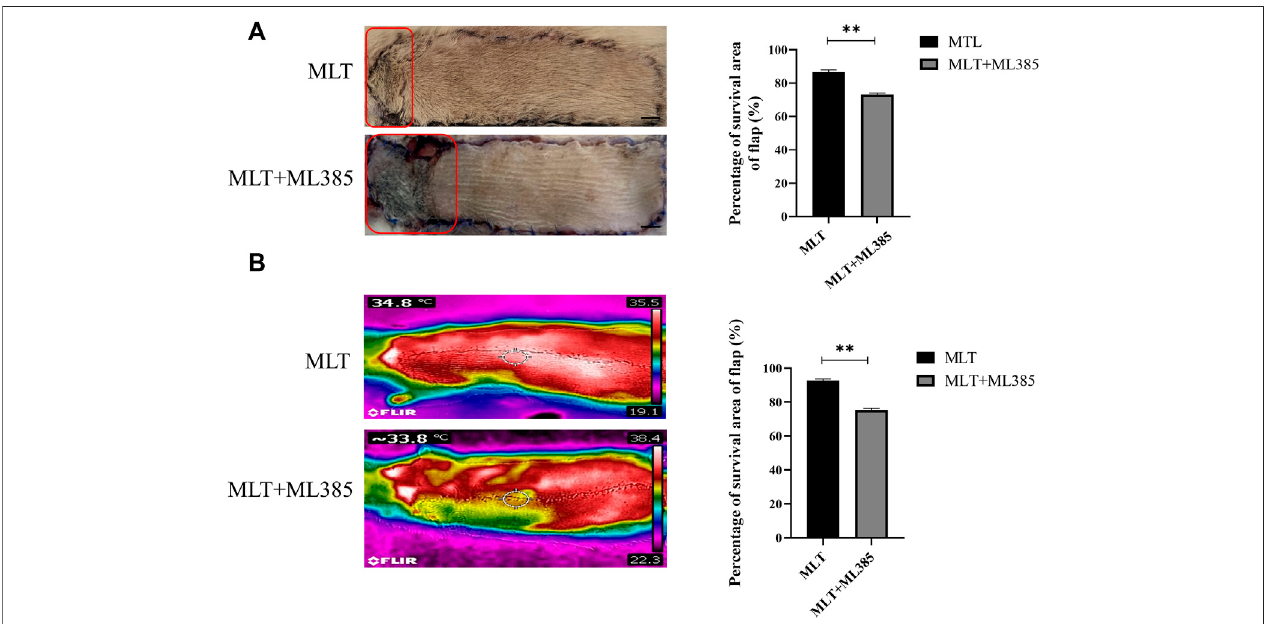
FIGURE 5 | MLT activated NRF2 to increase the survival area of the multidomain perforator fl ap. (A) Flap necrosis in the MLT group and MLT + ML386 group on postoperative day 7 and relative quanti fi cation of the fl ap survival rate. The red pane is the area of fl ap necrosis we marked. Signi fi cant differences between groups are expressedas** p < 0.001.Scalebar:1 cm (B) Flapblood fl owtemperatureintheMLTgroupandMLT+ML386groupandquantitativeestimationofthe fl apsurvivalrate. Columns represent the mean ± SEM, ** p < 0.001. Abbreviations: MLT,